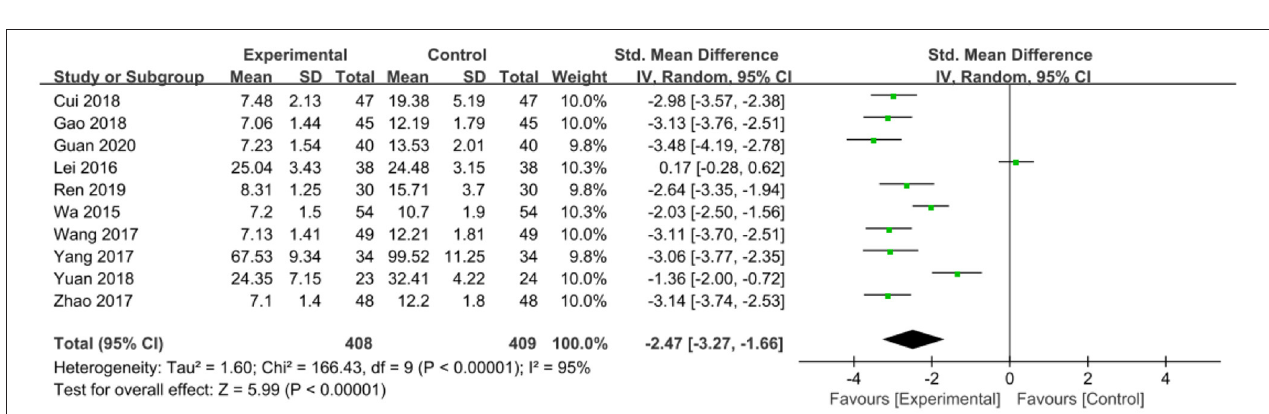
FIGURE 18 | Forest plots of IL-8 associated with experimental group (parenteral or enteral nutrition group supplemented with Gln) vs. control group (conventional nutrition group). I 2 tests and P are the criteria for the heterogeneity test, (cid:7) , pooled standard mean difference; — (cid:4) —, standard mean difference, and the edges of (cid:7) , 95% CI.